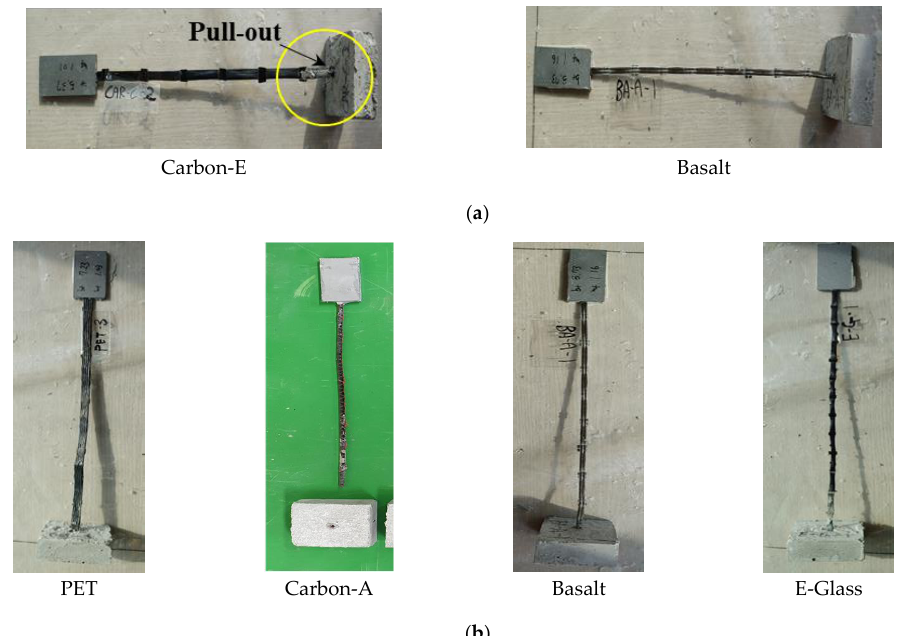
Figure 5. Failure in the pull-out series: ( a ) textile-type failure; ( b ) weaving-type failure.